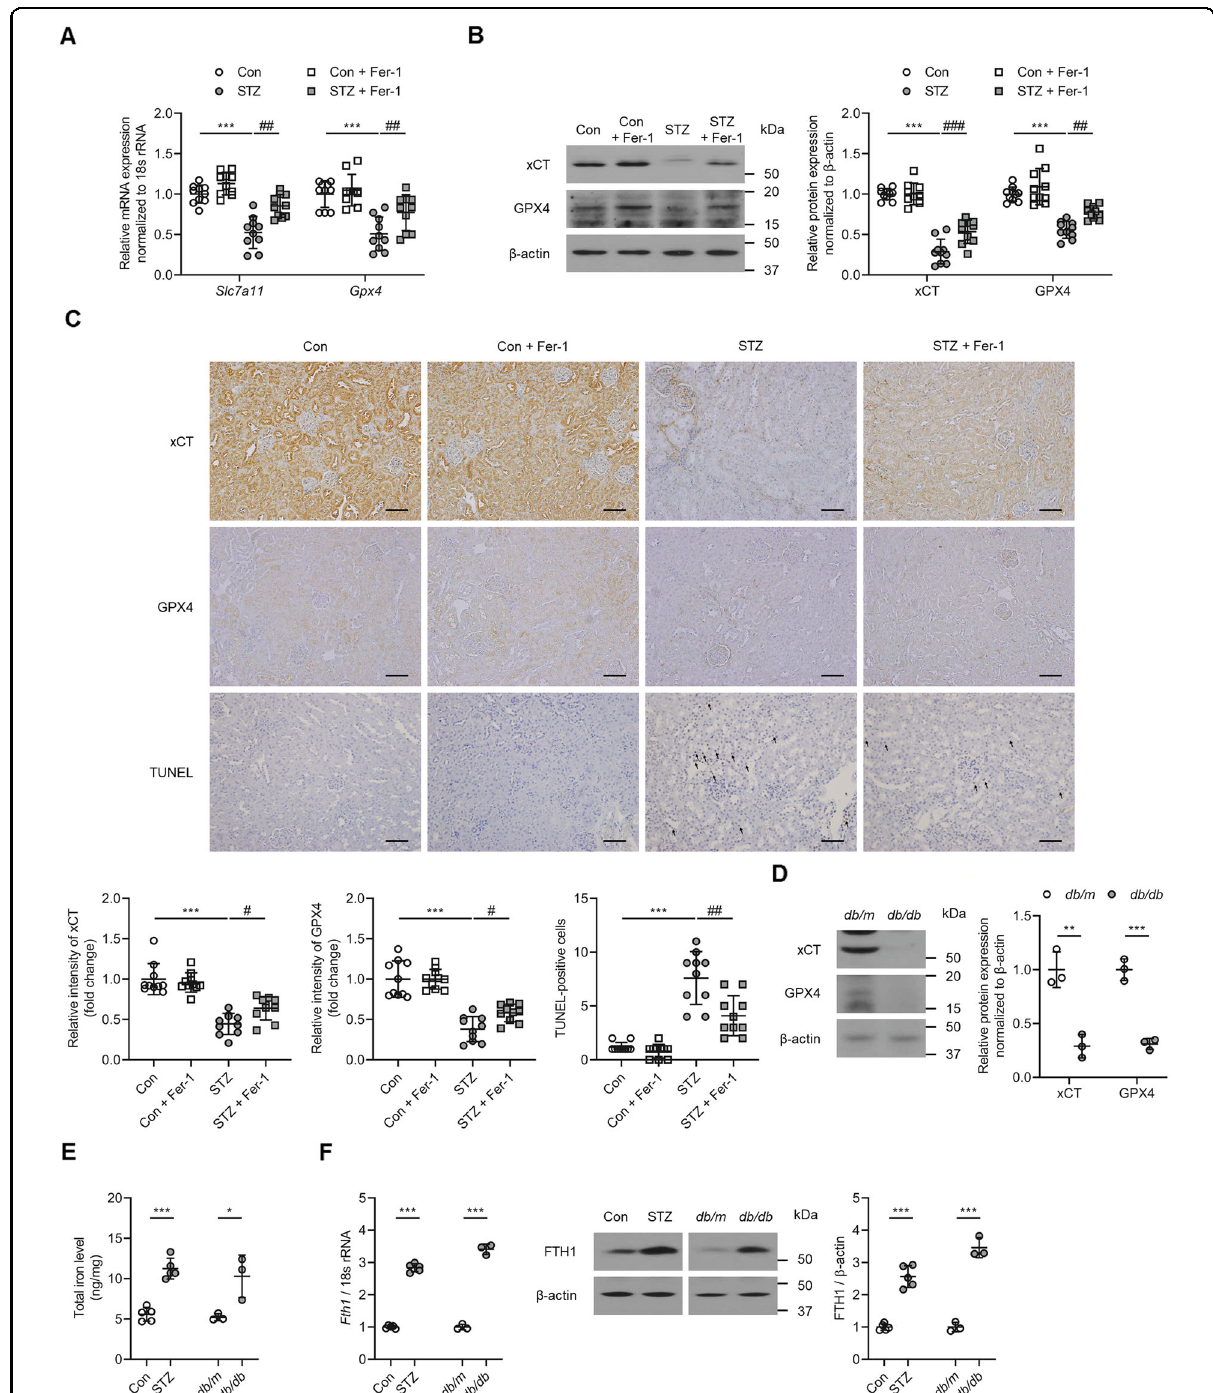
Fig. 5 Effect of Fer-1 on cell viability and changes in ferroptosis-related molecules in the kidney of diabetic mice. A Kidney Slc7a11 and Gpx4 mRNA expression was signi fi cantly lower in STZ mice than the Con group, and changes in the STZ kidney were abrogated by Fer-1 treatment. B xCT and GPX4 protein expression assessed by western blot was signi fi cantly lower in the STZ kidney, and this was ameliorated by administration of Fer-1. C TUNEL staining showed a signi fi cant increase in cell death in the STZ kidney, which was alleviated by Fer-1 treatment. D Protein and mRNA expression of xCT and GPX4 in kidney samples of db/db mice. E Total iron levels measured in kidney samples of STZ and db/db mice. F Protein and mRNA expression level of FTH1 in kidney samples of STZ and db/db mice. One-way ANOVA and Bonferroni post hoc tests were used for statistical analysis. Error bars represent SD. Original magni fi cation, ×20 for all. Scale bar = 100 µm. ** P < 0.01; *** P < 0.001 versus Con group. # P < 0.05; ## P < 0.01; ### P < 0.001 versus STZ group. n = 10 for each group of STZ. n = 3 for each group of db/db .